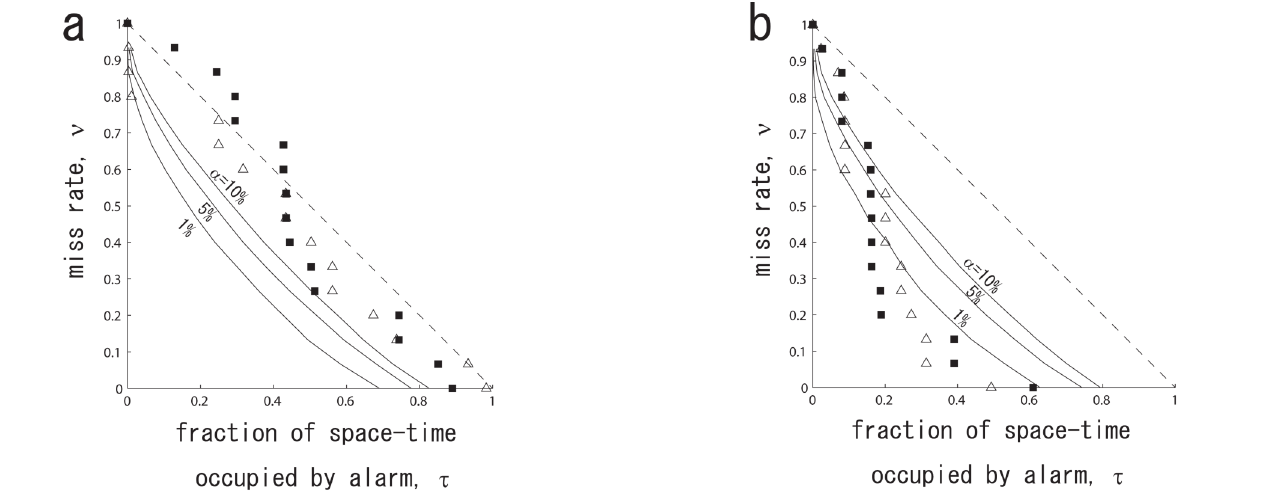
Figure 1. Molchan trajectory analysis. (a) PI (filled squares) and NSHM (open triangles) relative to the RI reference model. (b) RI (filled squares) and PI (open triangles) relative to the NSHM reference model. The Molchan trajectories are shown by the plots of the miss rate o as functions of fraction of space- time occupied by alarm x . Each plot also shows the a = 1%, 5% and 10% significance boundaries. In the Molchan trajectory plots, the points below these boundaries reject the null hypothesis. In (a), neither PI nor NSHM provide significant gain relative to RI. In (b), both PI and RI can be significantly better at forecasting future earthquakes than the NSHM for o ~0.0-0.5 at the 95% confidence level (or a < 5%). (a) is a reproduction using the data and program code supplemented in the online version of Zechar and Jordan [2008], while the same data and program code were used to create